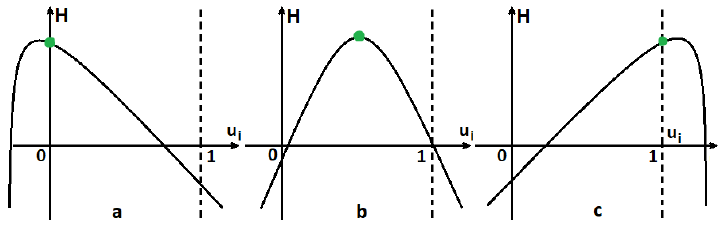
Figure 5. Hamiltonian function in a case in which functions h i ( · ) are convex.